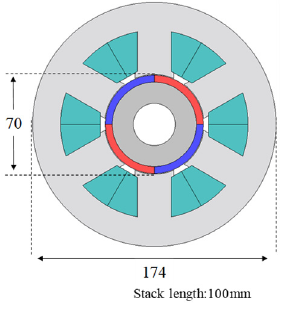
Table 2. Specifications of PMSM.